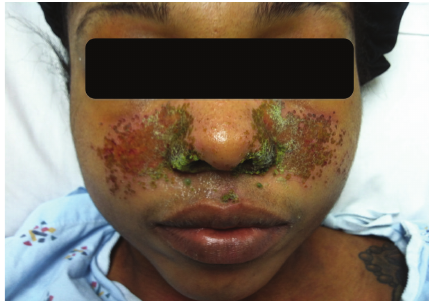
Figure 1: Case 1 demonstrates facial eczema herpeticum.